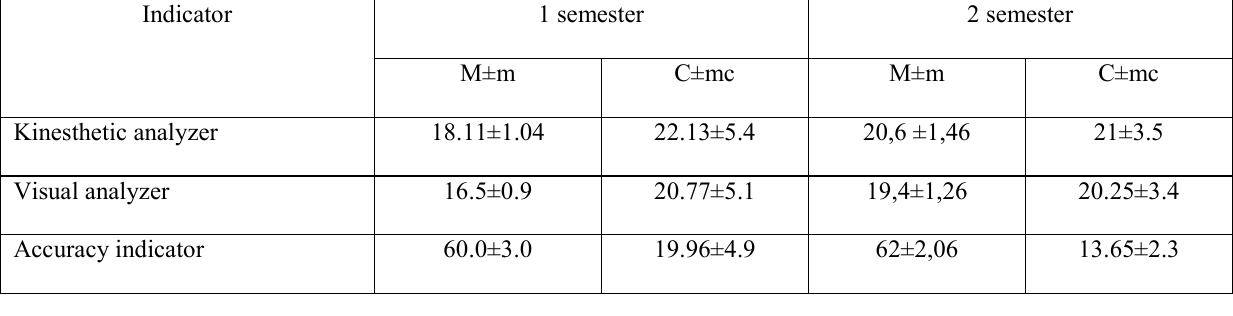
Indicators of sensing metering and accuracy of physical exercises’ fulfillment, depending on duration of total time of study at HEE (mean value of minimal sensations’ increment (М±m) and accuracy of exercise’ fulfillment С±mс %)